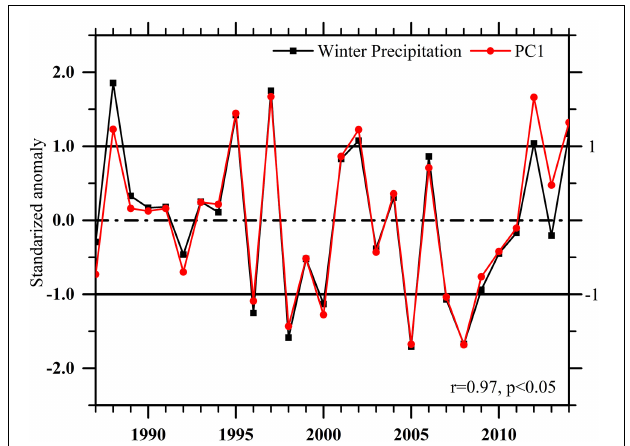
FIGURE 6 | Inter–annual variability of PC1 and winter precipitation anomaly over Nepal. The black dotted line represents the reference line and blackline separates the wet and dry years during 1987–2015.